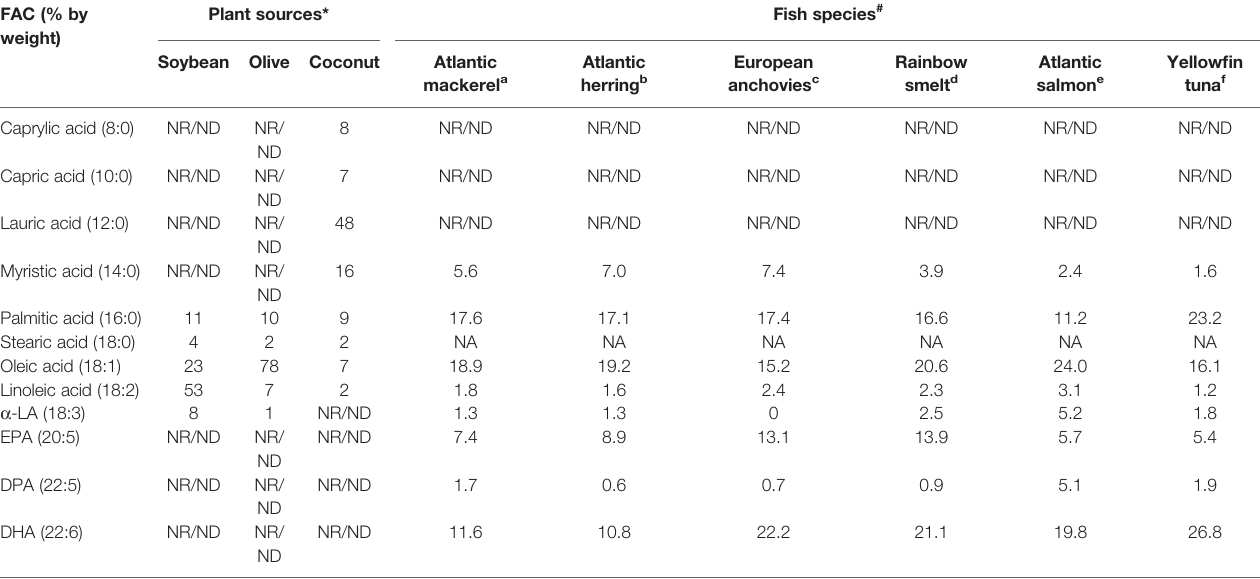
TABLE 3 | Fatty acid composition in selected plant and fi sh sources used in intravenous lipid emulsions. FAC (% by Plant weight)